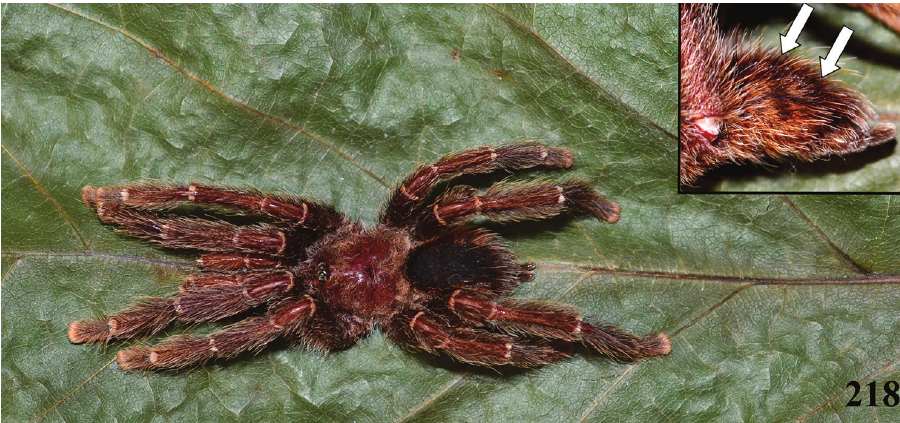
Figure 218. Avicularia caei sp. n, holotype, habitus, preserved male (MPEG 015637). Detail: lateral abdomen. Arrow indicating stripes. Photo: C. S.